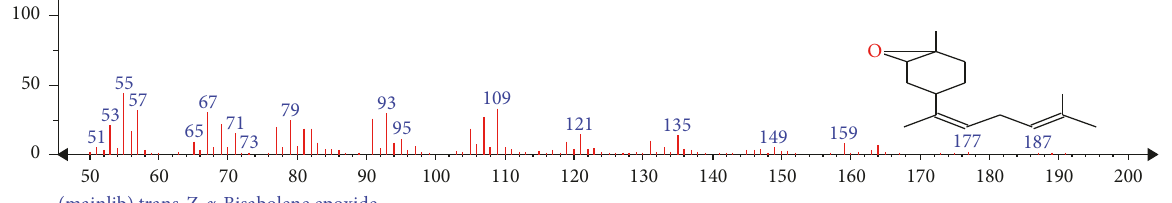
epoxide50 60 (mainlib) trans-Z- α -Bisabolene Figure 37: Mass spectrum of compound trans-Z- α -bisabolene epoxide of whole plant hexane fraction of Achillea wilhelmsii (WHFAW).